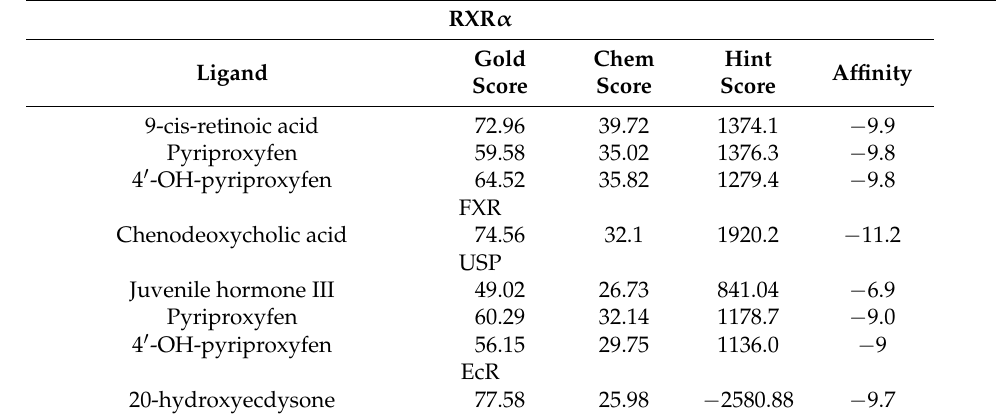
Table 1. Molecular docking results of the natural ligands, pyriproxyfen, and 4 (cid:48) -OH-pyriproxyfen against A. mellifera and H. sapiens ’